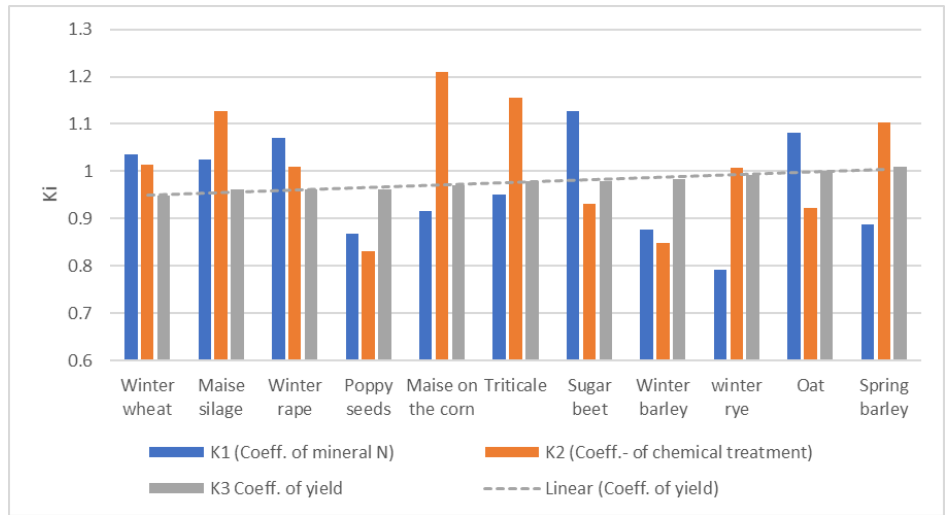
Figure 6. Coefficient Ki of the ratio of the individual monitored indicators.